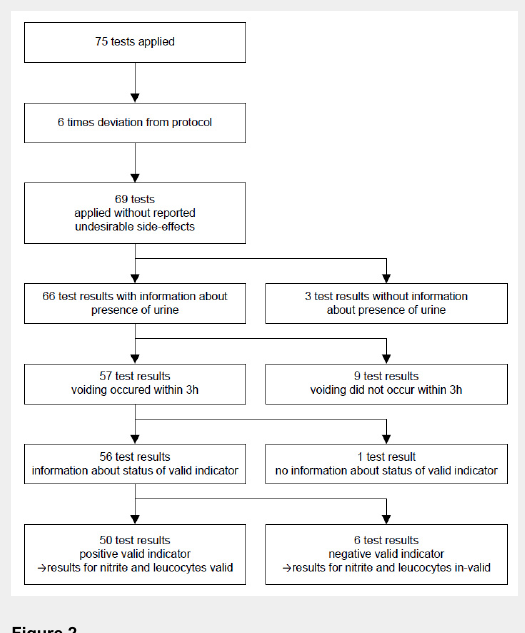
Figure 2 Results of the clinical study for the qualitative parameters